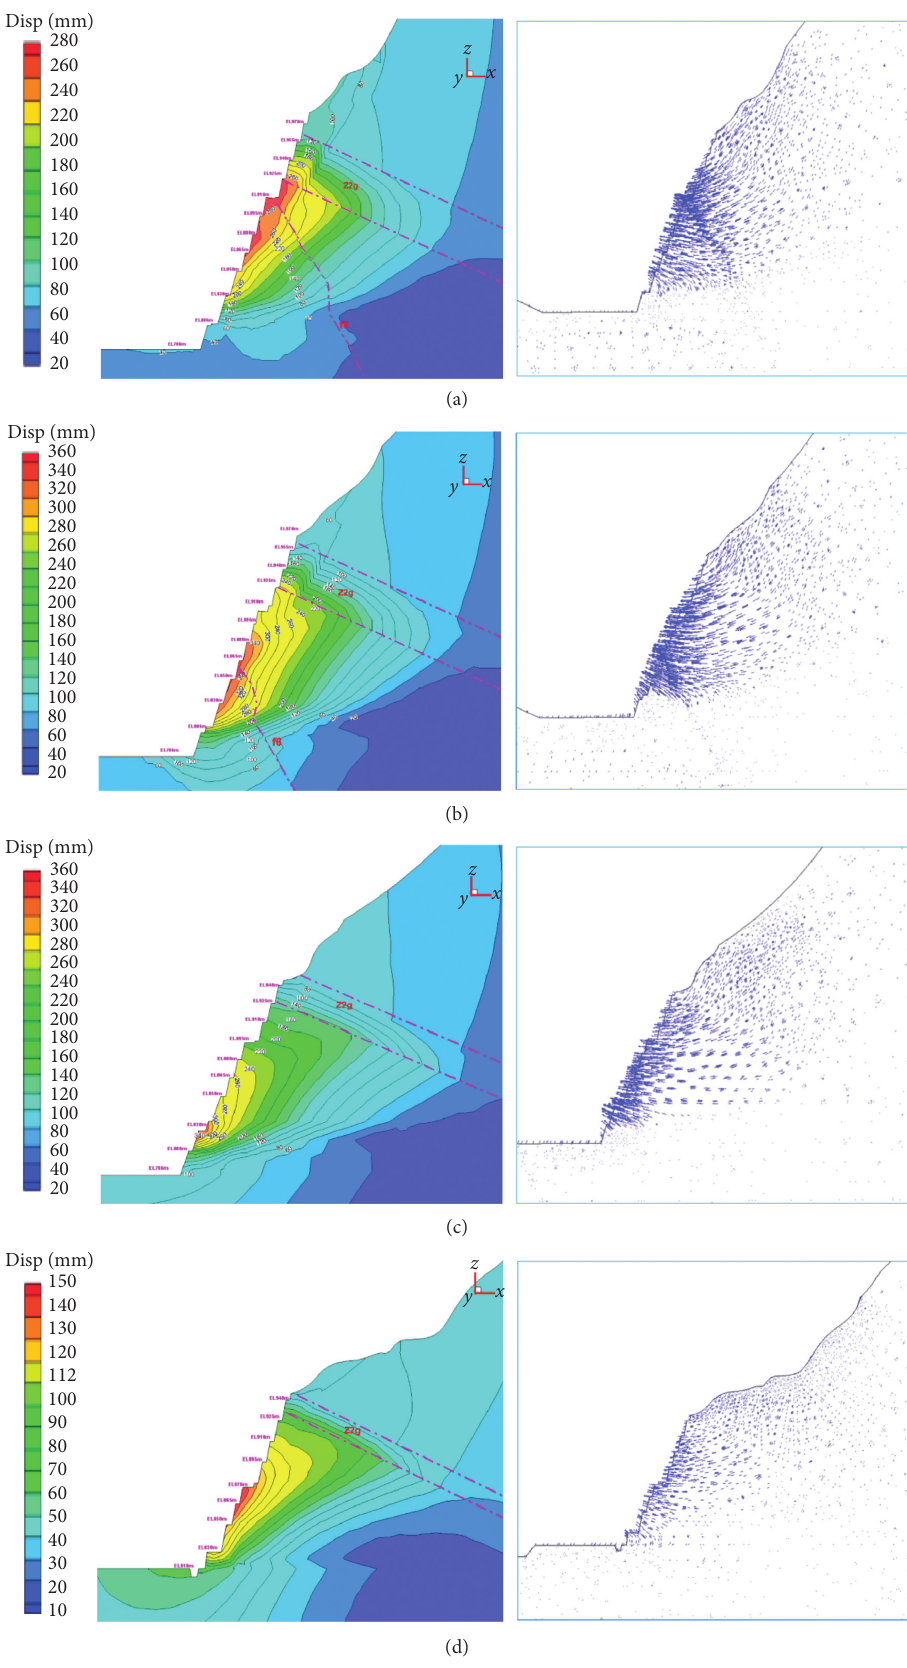
Figure 7: Displacement field and deformation vector diagram of (a) section 1, (b) section 2, (c) section 3, and (d) section